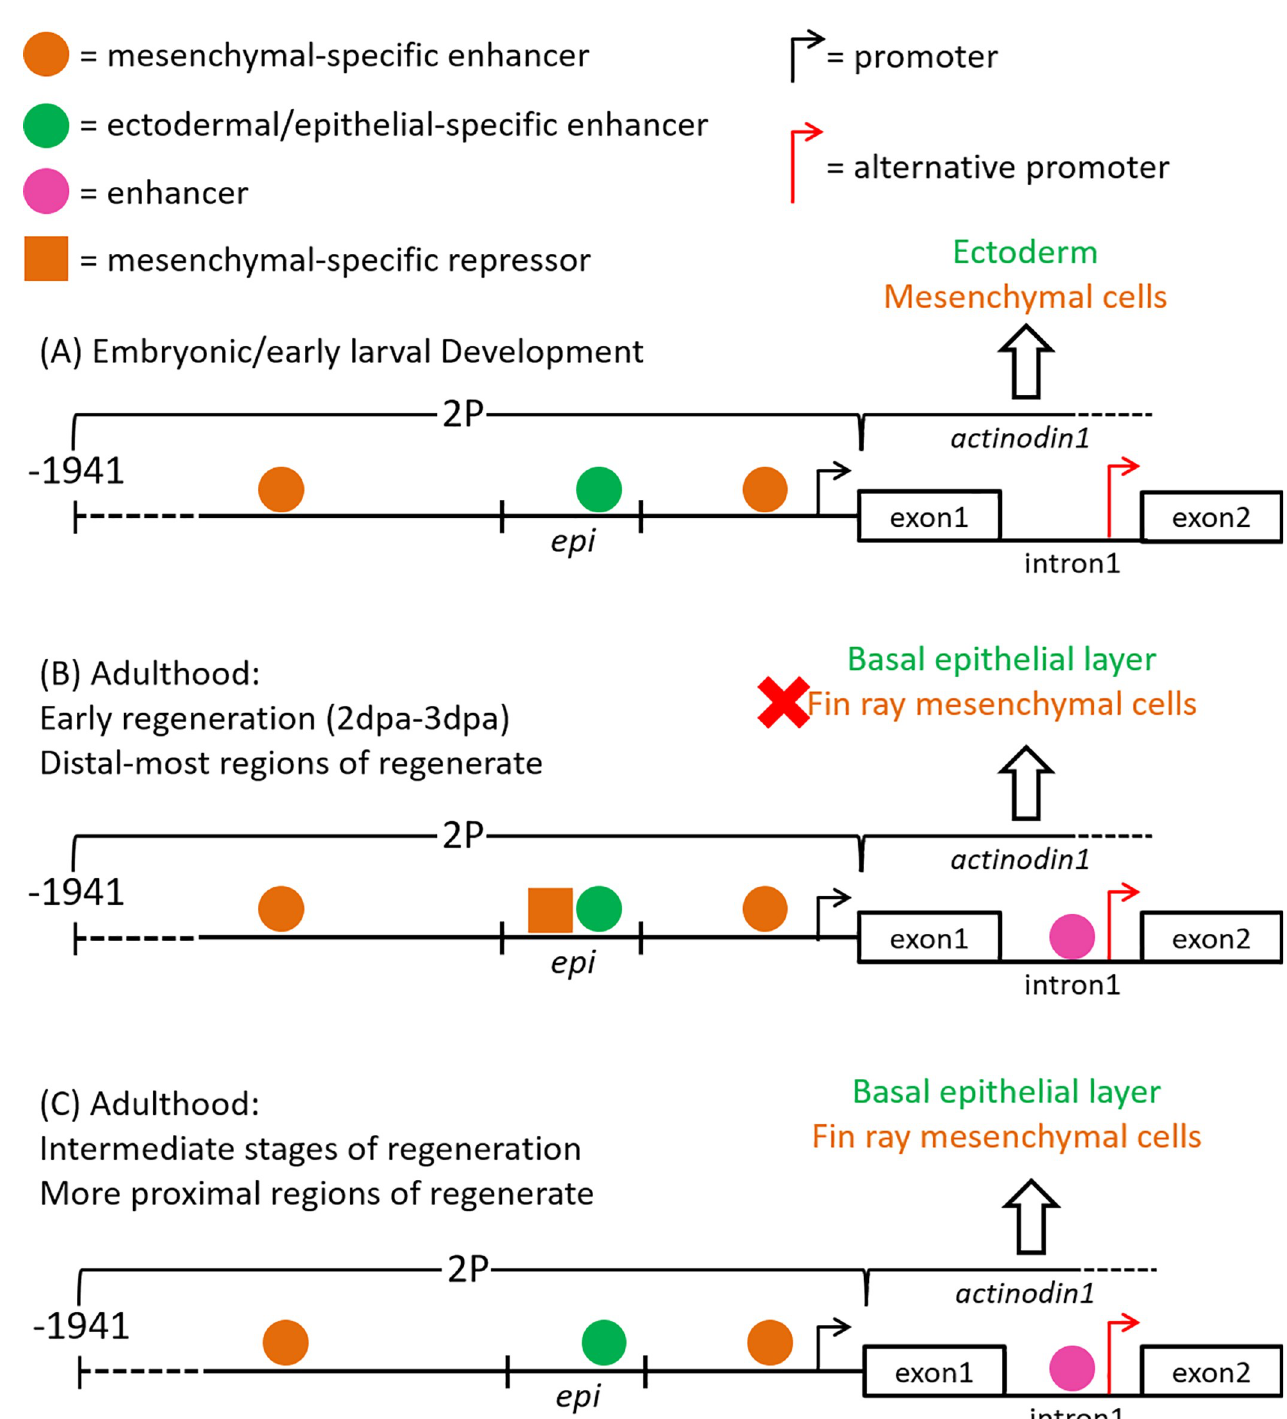
Fig 7. Regulation of actinodin1 during embryonic and early larval development, and during adult fin regeneration. (A) During early larval development, the ectodermal-specific enhancer binds to the epi region, while mesenchymal-specific enhancers bind to the 2P regions outside of epi . These enhancers, together, promote and1 expression in the ectoderm and migrating mesenchymal cells of the fin fold. (B) During the early stages of regeneration and in the distal-most regions of the regenerating fin, fin ray mesenchymal-specific actinodin1 expression is inhibited, perhaps through the binding of a strong repressor within the epi region. In parallel, strong actinodin1 expression occurs within the basal epithelial layer due to the binding of an epithelial-specific enhancer at the epi region and perhaps at various enhancer sequences within the EI region. The repressor effects at the level of epi appear to override intron-mediated enhancement. (C) During the intermediate stages of regeneration, within the more proximal regions of the regenerate, the absence of the epi -specific repressor and the persistence of intron-mediated enhancement allows for strong actinodin1 expression in the basal epithelial layer and in the fin ray mesenchyme. https://doi.org/10.1371/journal.pone.0216370.g007 PLOS ONE | https://doi.org/10.1371/journal.pone.0216370 May 2,